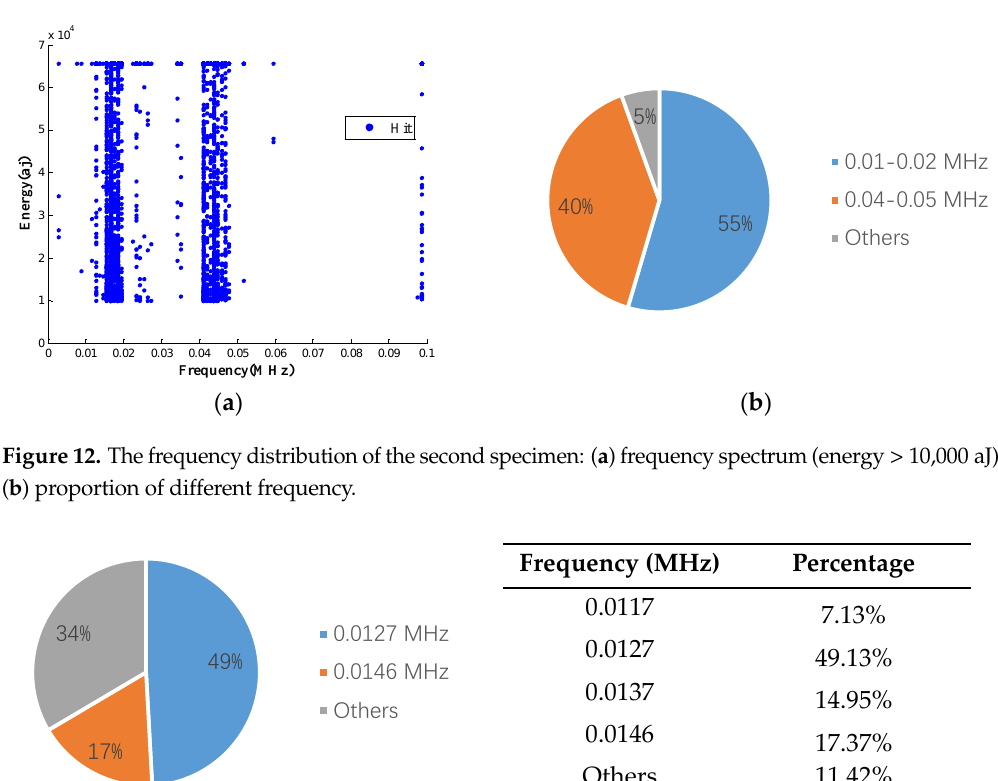
Figure 11. The frequency distribution of the first specimen: ( a ) frequency spectrum (energy > 10,000 aJ); ( b ) proportion of different frequency.